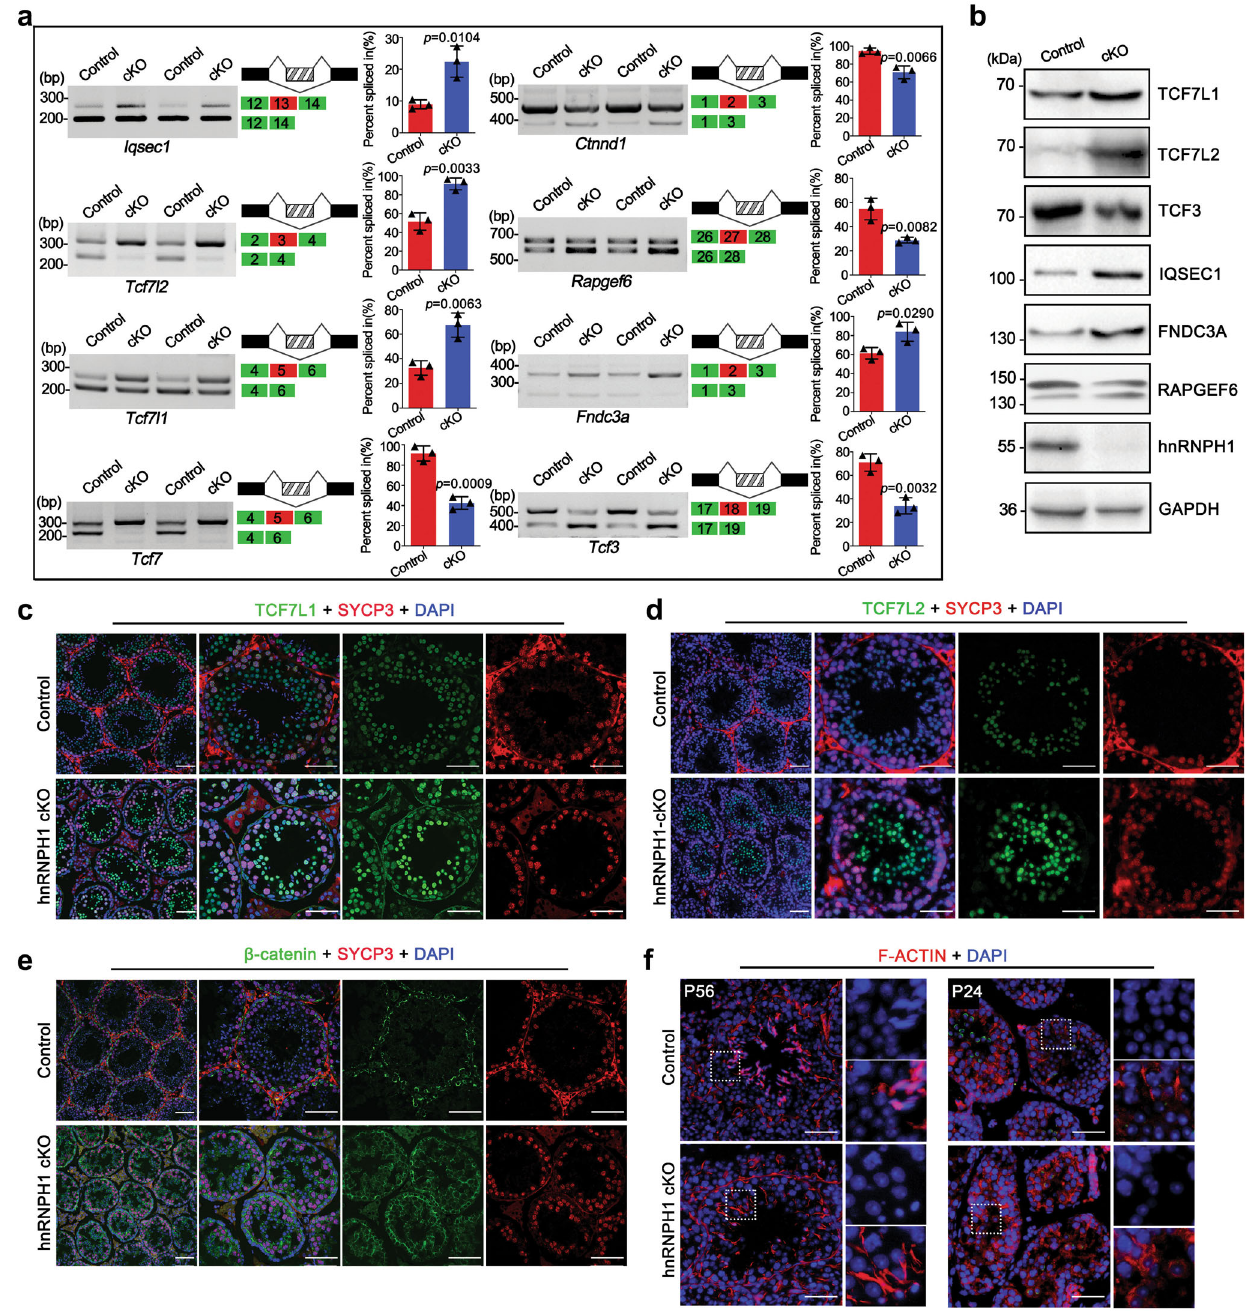
Fig. 6 Ablation of hnRNPH1 in germ cells results in abnormal AS of cell junction-related genes and defective germ-Sertoli cell communications. a Representative examples of RT-PCR analyses for indicated AS events differentially regulated genes between control and hnRNPH1 cKO round spermatids are shown. Middle panels represent the schematic diagram of alternatively spliced exons detected by RNA-Seq analysis. Right panels show the quanti fi cation of percent spliced in (PSI). Data were presented as mean ± SD, n = 3 (three biological replicates). A two-sided Student ’ s t -test was performed. b Western blotting analyses of the expression of TCF7L1, TCF7L2, TCF3, IQSEC1, FNDC3A, RAPGEF6, and hnRNPH1 in control and hnRNPH1 cKO round spermatids isolated from P25 mice. GAPDH was used as a loading control. c – e Co-immuno fl uorescence staining of SYCP3 with TCF7L1 ( c ), TCF7L2 ( d ), and β -catenin ( e ) on testis sections from control and hnRNPH1 cKO mice at P56. Scale bars = 50 µ m. f Fluorescence microscopy to detect F-ACTIN (phalloidin) and DNA (DAPI) in testes from control and hnRNPH1 cKO mice at P56 (left panels) and P24 (right panels). Scale bars = 50 µ m. Biologically independent mice ( n = 3) were examined in three separate experiments ( b – f hnRNPH1-RNA interactions 27 . Upon comparing RNA-seq and RIP-seq data, we found that ~23% (200 out of 881) and ~22% (205 out of 967) alternative splicing-changed genes were bound by hnRNPH1 in spermatocytes and spermatids, respectively (Fig. 8c).